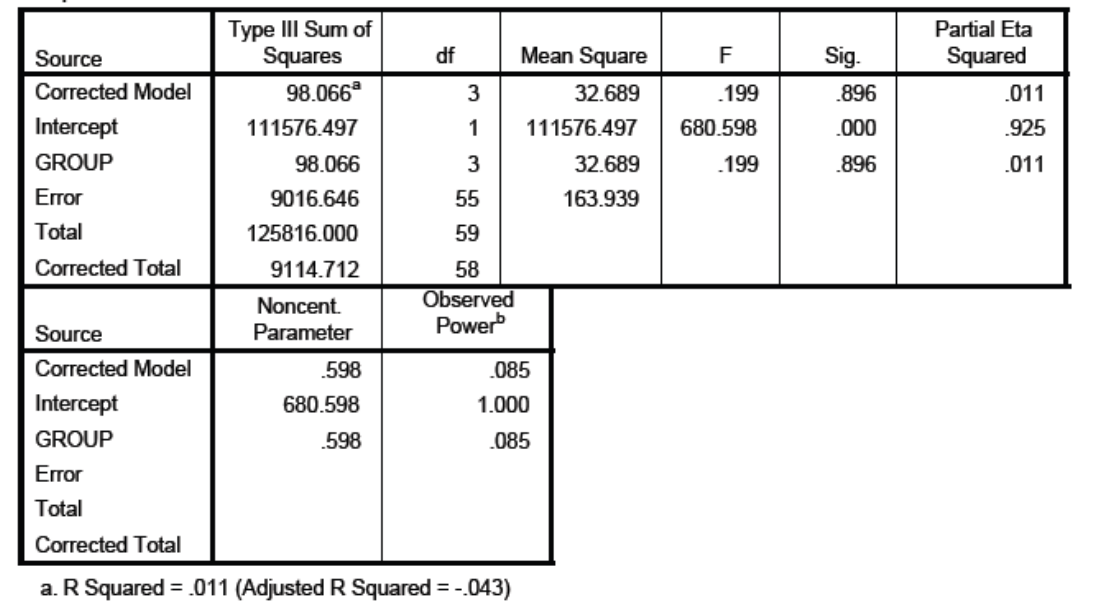
Figure B.4. ANOVA analysing engagement levels between the four groups of participants using raw data for participants who correctly indicated their